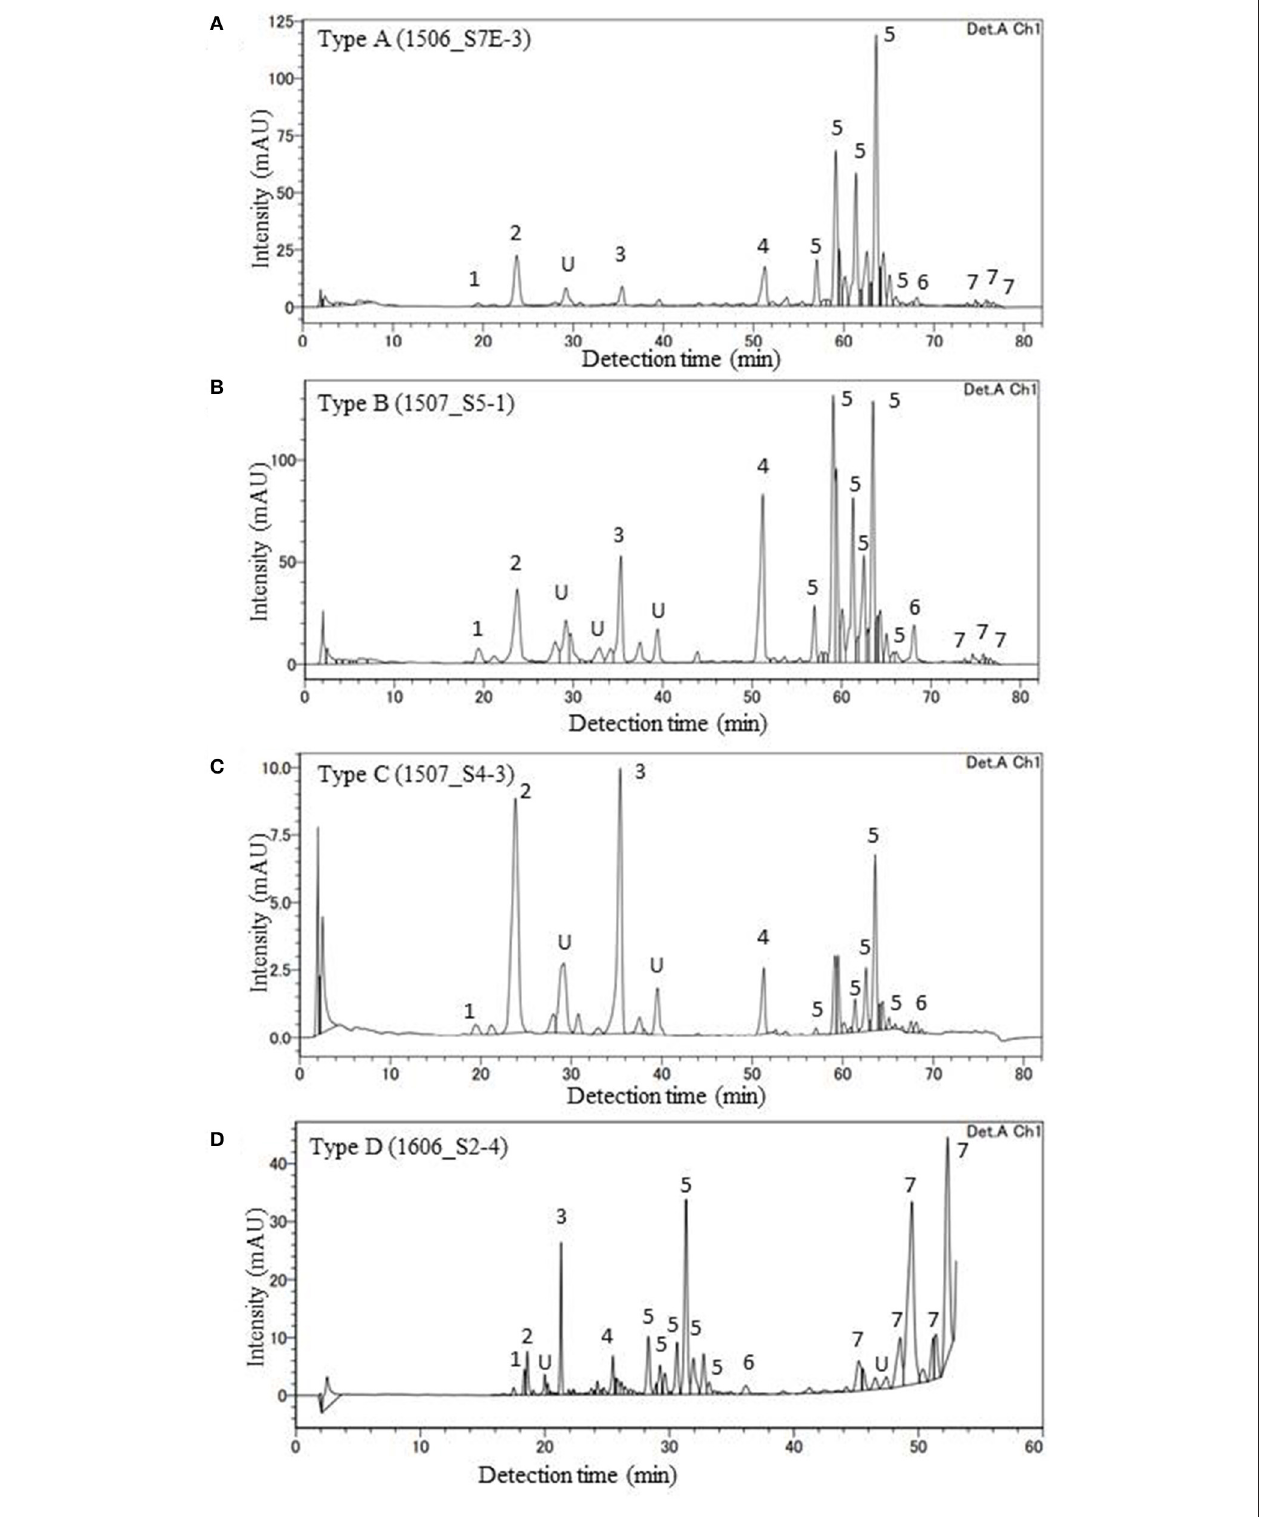
FIGURE 4 | HPLC chromatograms of four major pigment types of red snow samples ( A : Type A, B : Type B, C : Type C, D : Type D) in this study (detection wavelength: 450nm). Peaks with numbers or alphabet in the chromatograms indicate the algal pigments identified in this study. 1: Violaxanthin, 2: Astaxanthin, 3: Lutein, 4: Chlorophyll b , 5: trans-Astaxanthin (monoester), 6: β -carotene, 7: trans-Astaxanthin (diesters), and U: Unknown.